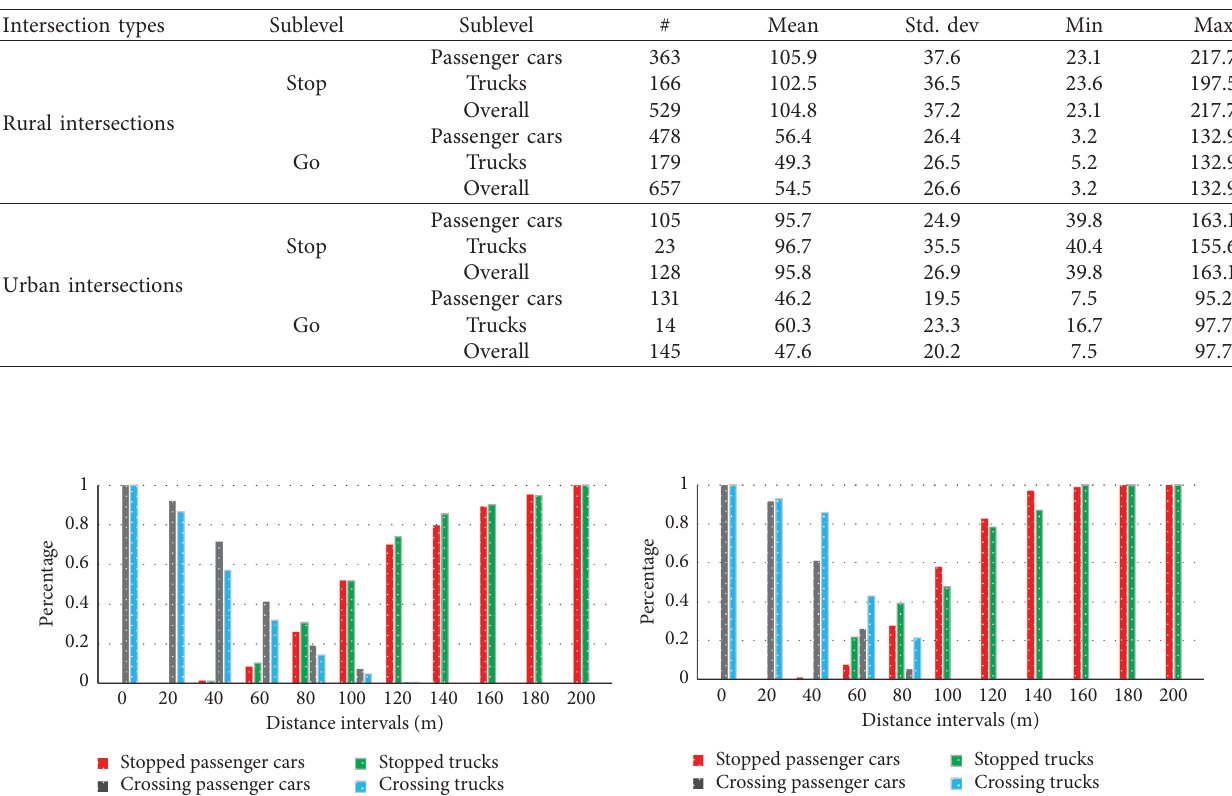
Table 3: Descriptive statistics for distance to the intersection at the beginning of FG (unit: m).